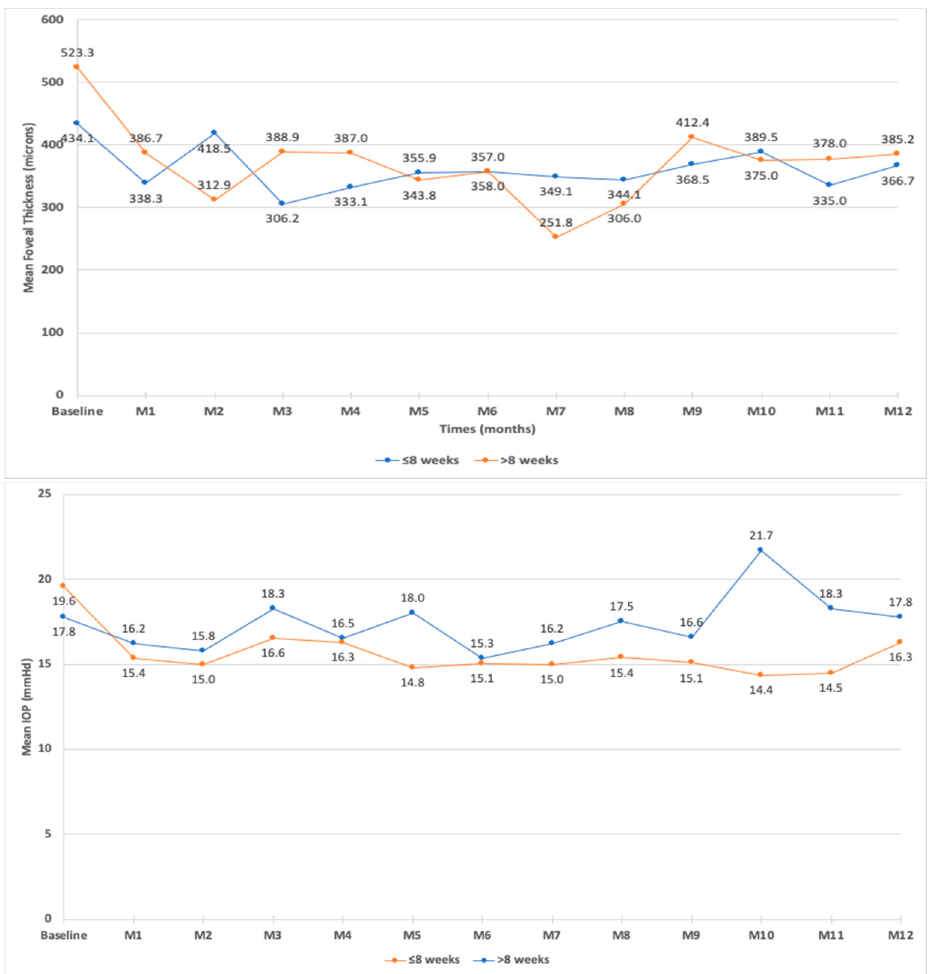
Figure 2. Mean central macular thickness (CMT) and mean change in CMT during the follow-up after fluocinolone acetonide implant injection.